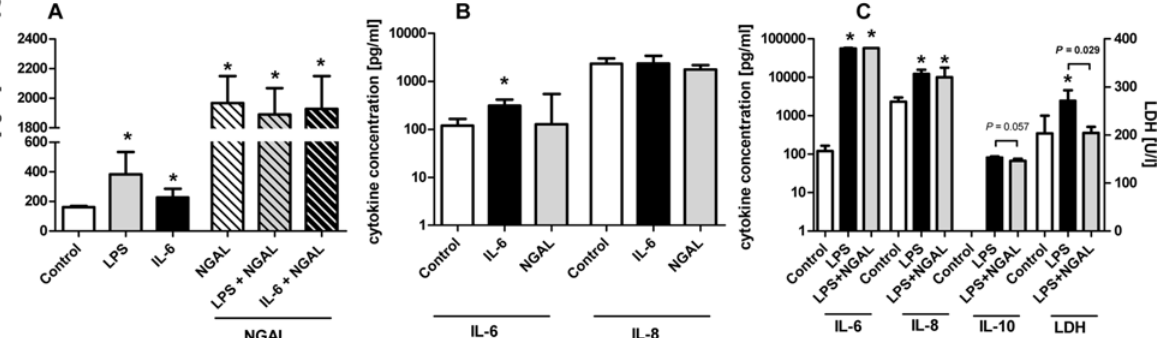
Fig 2. In-vitro stimulation of whole blood. Stimulation experiments with IL-6, LPS, NGAL or their combinations with a total numbers of n = 4 are presented. (A) NGAL levels in vehicle controls (open bar) and after stimulation with LPS (grey filled bar), IL-6 (black filled bar), and after stimulation with only NGAL (open, striped bar), NGAL + LPS (grey, striped bar) and NGAL + IL-6 (black, striped bar). (B) Cytokine levels of IL-6 and IL-8 in control (open bars) and after stimulation with IL-6 (black) or NGAL (grey). (C) Cytokine levels of IL-6, IL-8, IL-10 as well as levels of LDH in control (open bars) and after stimulation with LPS (black) or LPS+NGAL (grey). * P < 0.05 compared to vehicle control or indicated by clamp to corresponding group. Bars and error bars represent median values and interquartile range.